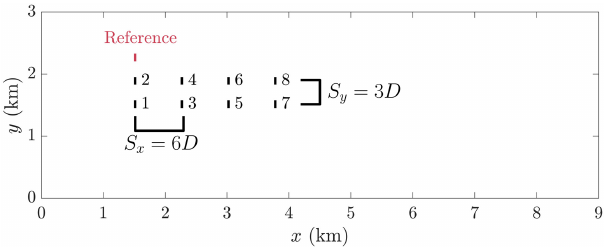
Figure 1. The wind farm layout considered in this study within the domain of interest (excluding the sections influenced by the fringe region). The reference turbine (shown in red) is used for power nor- malization and uses yaw alignment control for each